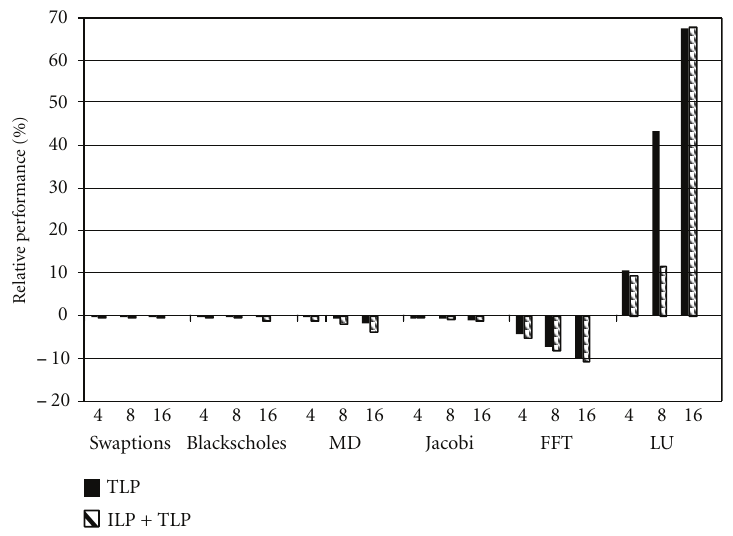
Figure 6: Performance comparison regarding di ff erent application data set sizes.